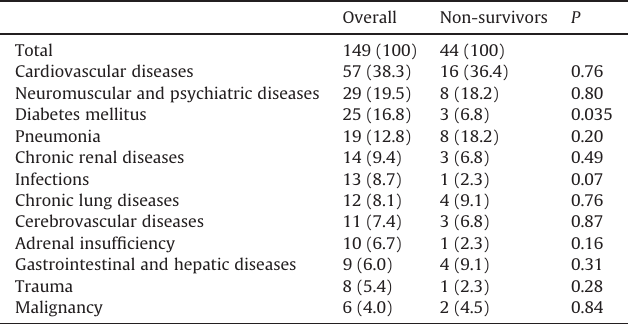
Table 2 Comorbidities at admission.